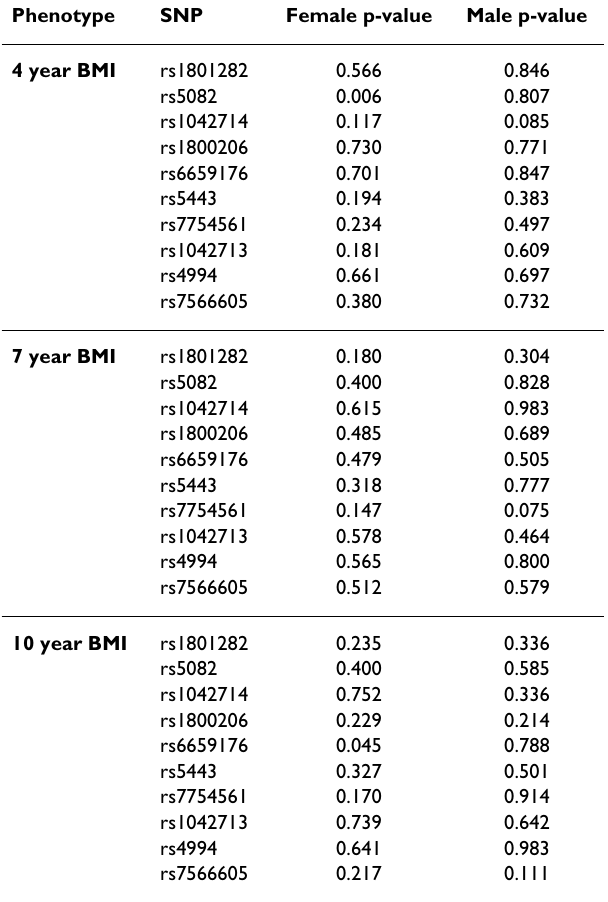
Table 4: Results from gender-specific QTDT for BMI z-scores at 4, 7 and 10 years